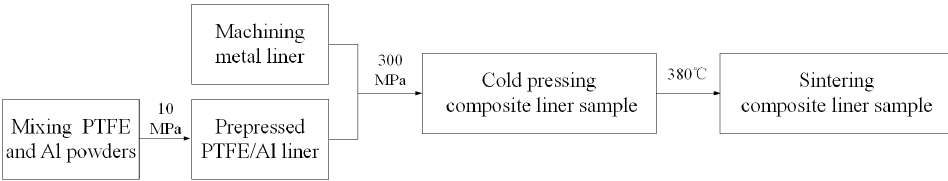
Figure 1. The flowchart of the reactive material composite liner preparatory process. The schematic structure and samples of the reactive material composite liners are shown in Figure 2. In these experiments, the formula design of the reactive materials was composed of 73.5 wt.% PTFE and 26.5 wt.% Al powder. After the cold pressing and